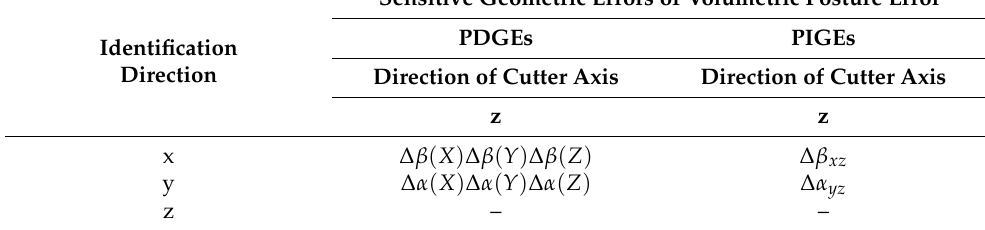
Table 5. Sensitive geometric errors of volumetric posture error of structure in Figure 9 based on Table